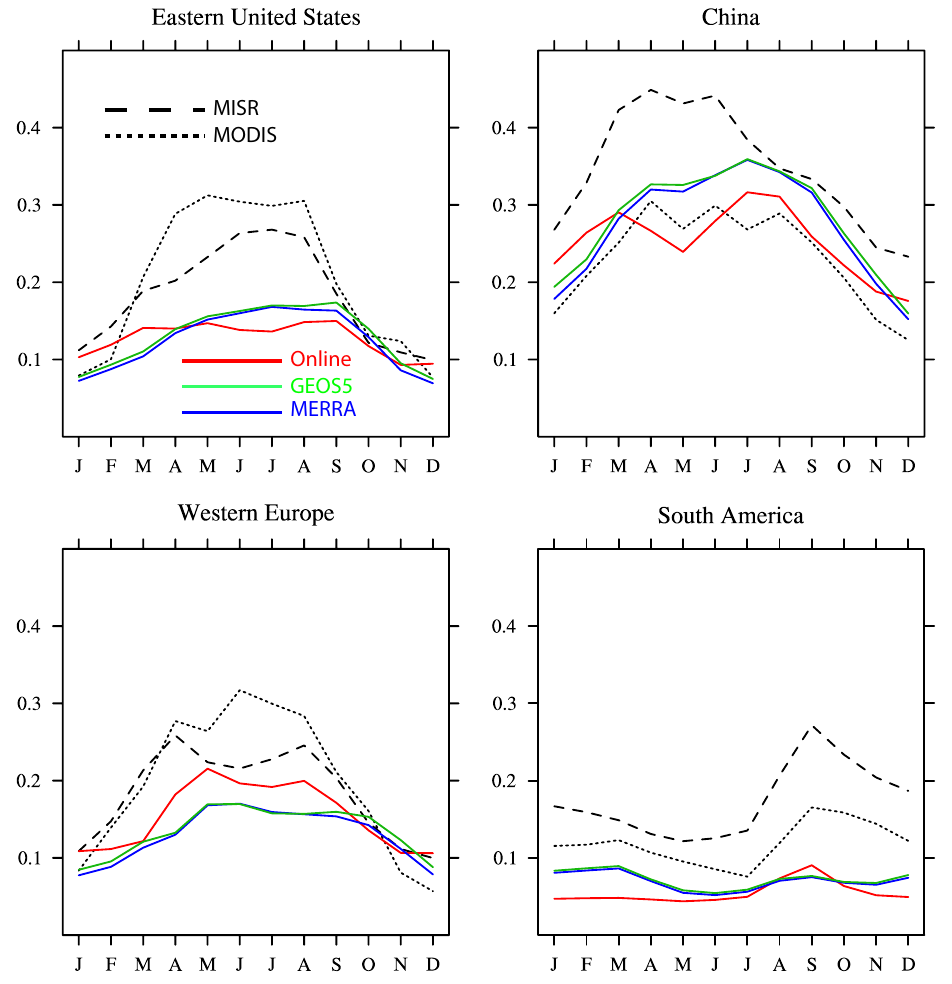
Fig. 15. Seasonal cycle of the aerosol optical depth from MODIS and MISR over specific regions.